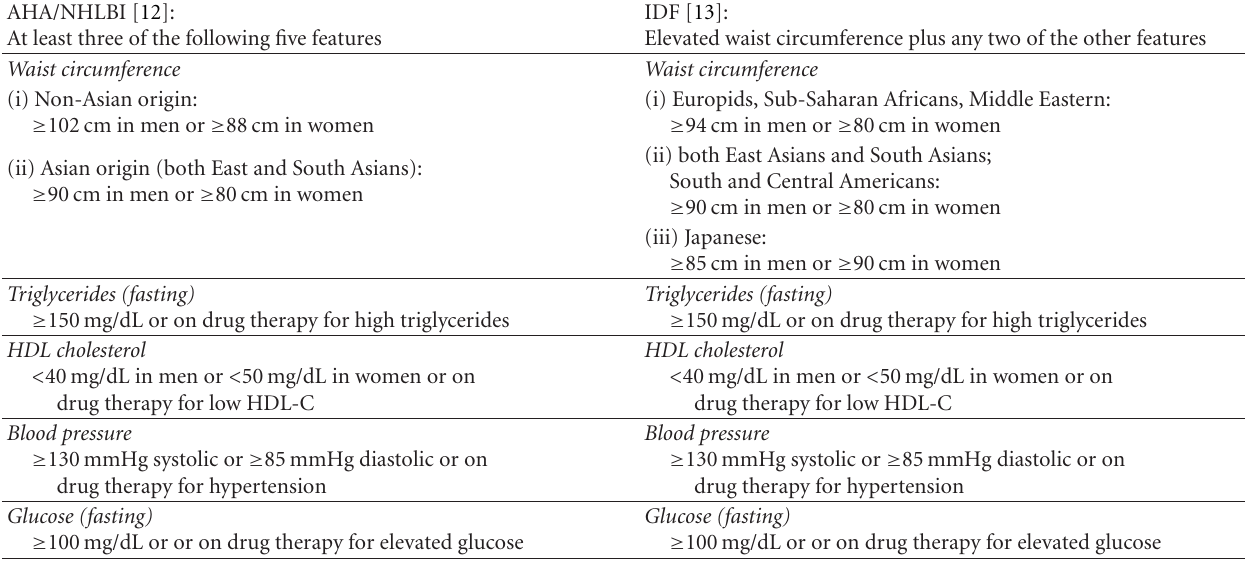
Table 1: The most widely used definitions for metabolic